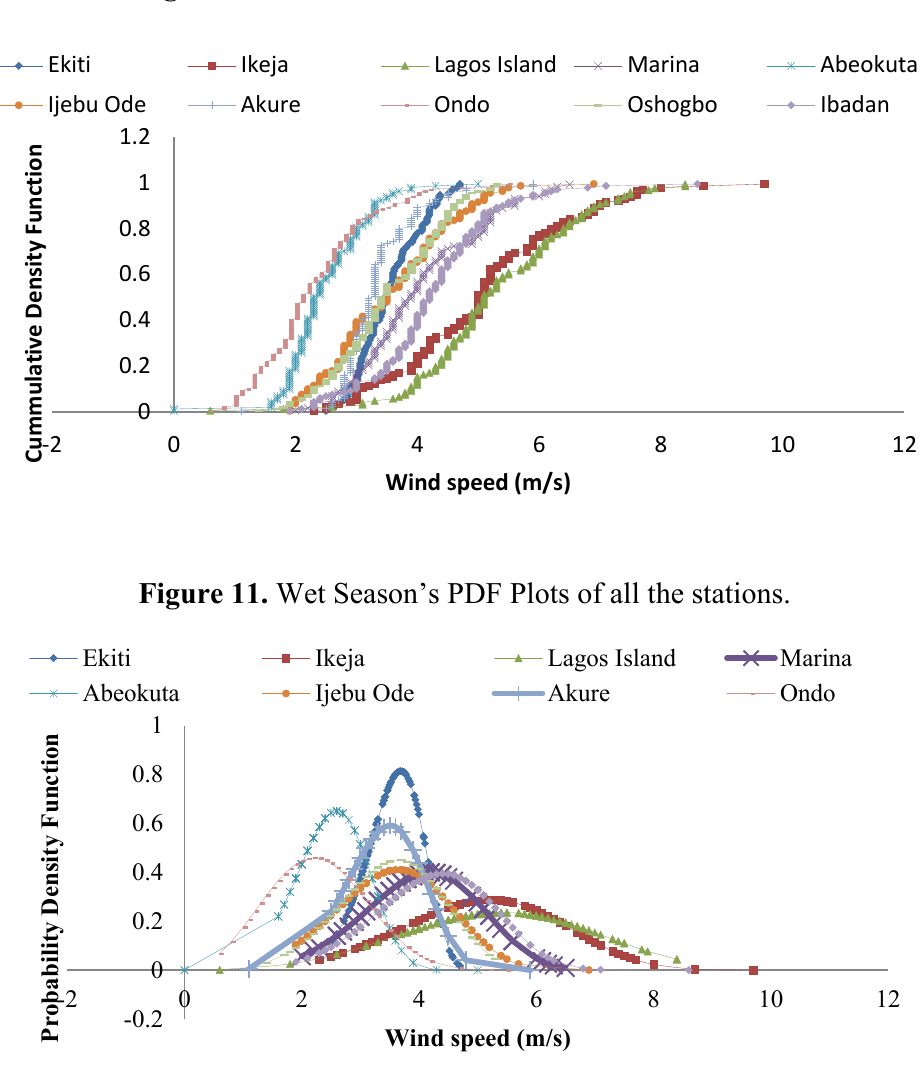
Figure 10. Wet Season’s CDF Plots of all the stations.